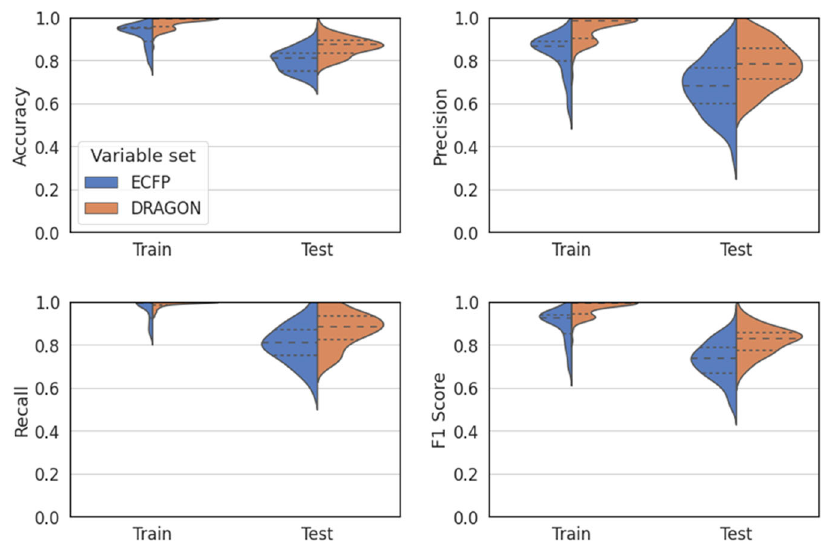
Fig. 7 Violin plots for the results of the two-class classi fi cation. The distributions of four metrics (accuracy, precision, recall, and f1 score) of the two- class classi fi cation for two variable sets (ECFP and DRAGON) are depicted in the violin plots. The dashed lines represent quartiles (25%, 50%, and 75%). The performance of the model with DRAGON outperforms that with ECFP for each metrics. The lower quartiles indicate that the random forests classi fi er (RFC) generated practical classi fi cation models for DRAGON with accuracies >0.83 (precisions >0.71, recalls >0.83, and f1 scores >0.77), whereas slightly inferior models for ECFP with accuracies >0.75 (precisions >0.60, recalls >0.75, and f1 scores